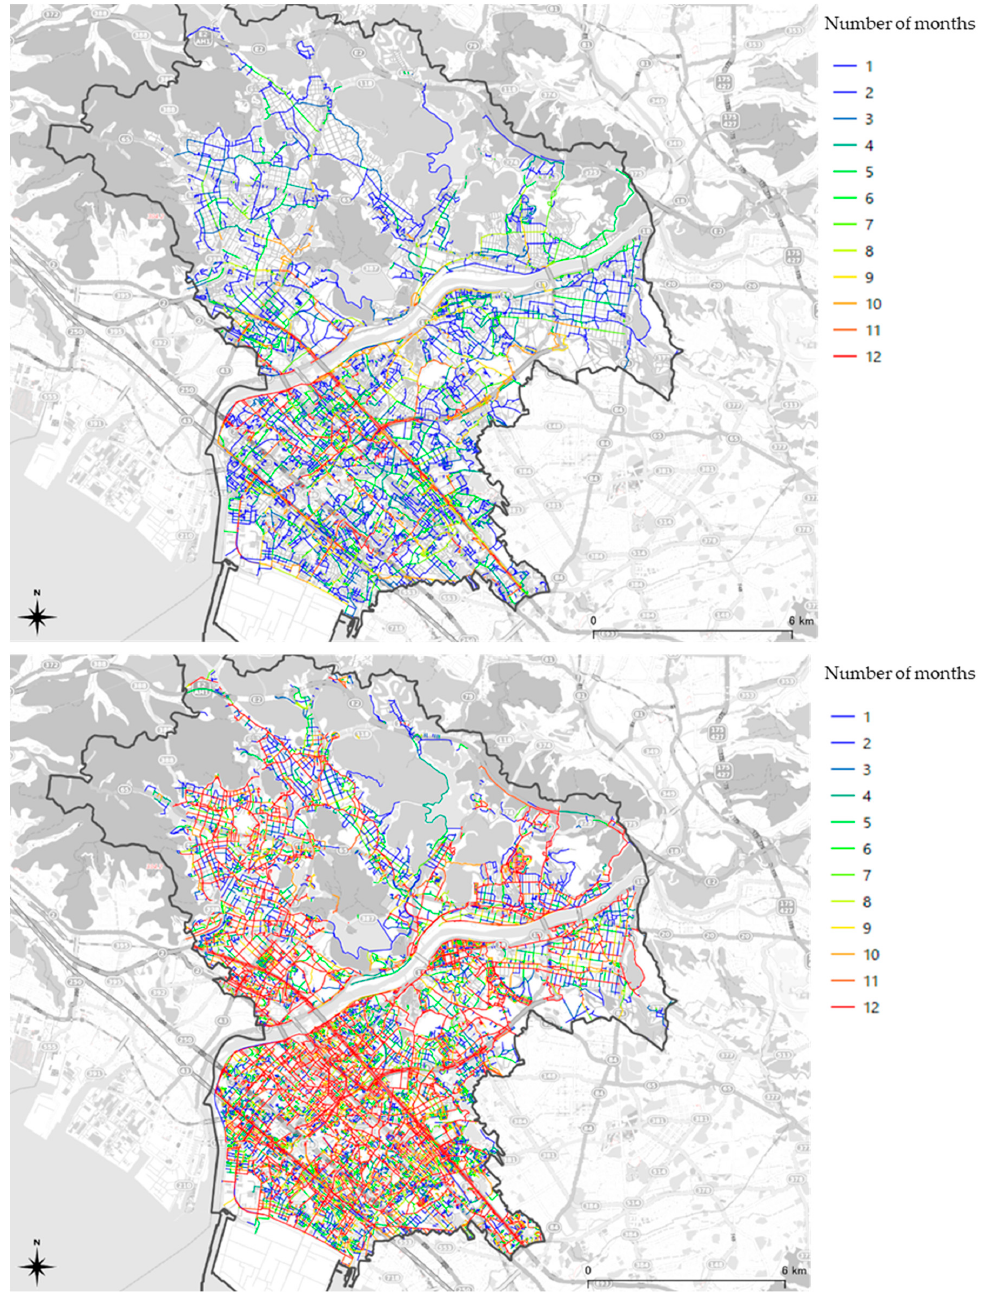
Figure 4. Number of months a road segment is used in Kakogawa City; Left: Seven road management vehicles, Right: All public vehicles.